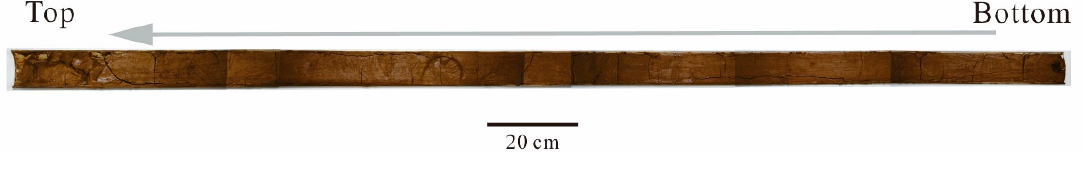
Figure 2. Appearance characteristics of GC1601.